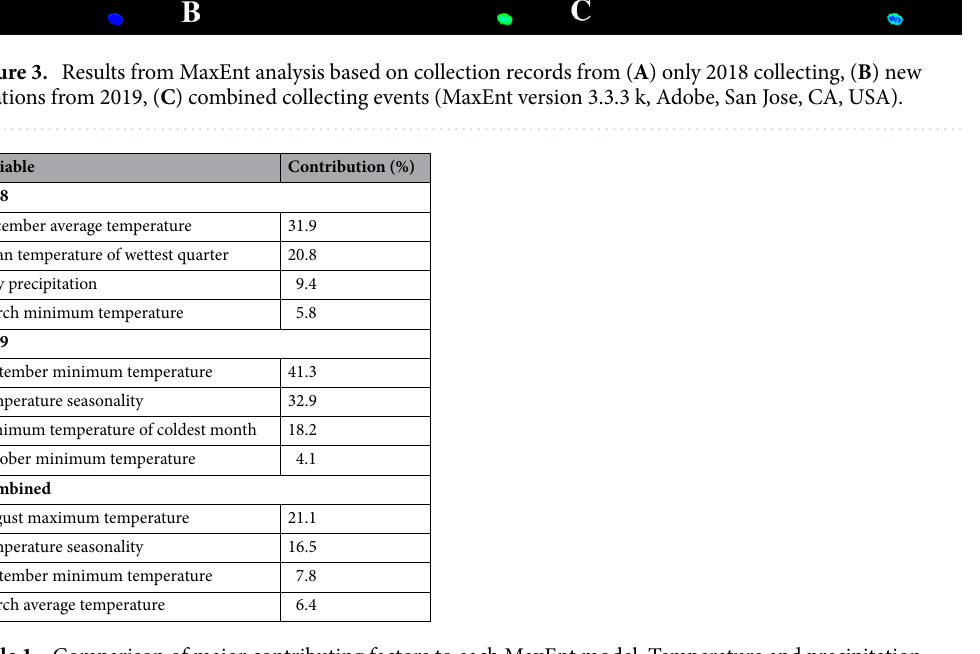
Table 1. Comparison of major contributing factors to each MaxEnt model. Temperature and precipitation are frequently used in model training in both aquatic and terrestrial systems, we found this to be the case as well. Since both coastal species of Atyphella from Vanuatu spend the majority of the time in the intertidal zone submerged by water, precipitation is not as influential if they were a completely terrestrial